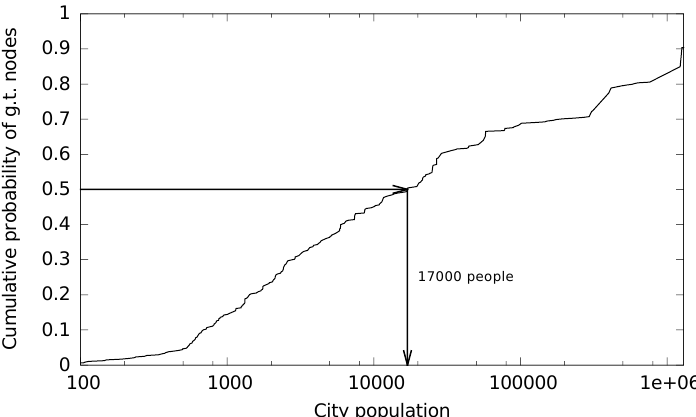
Figure 3. Groundtruth devices in cities with different